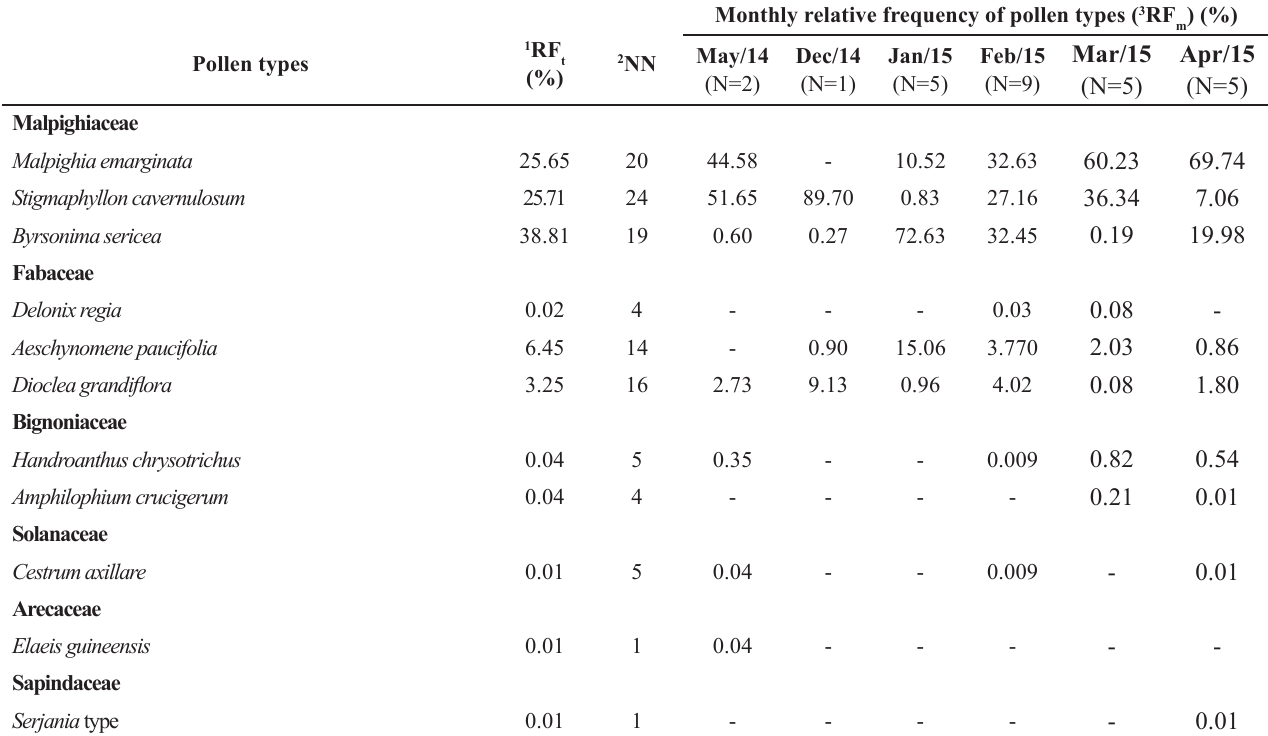
Table 2. Relative frequencies of pollen types in larval food from 27 nests of Centris analis (Fabricius, 1804) collected from Parque